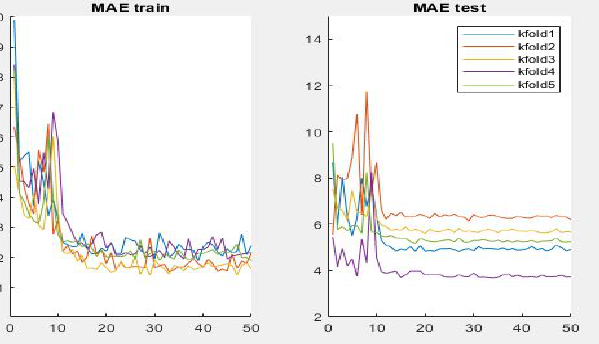
Figure 7. Results of evaluation metric MAE for CNN Densenet-161 with optimizer